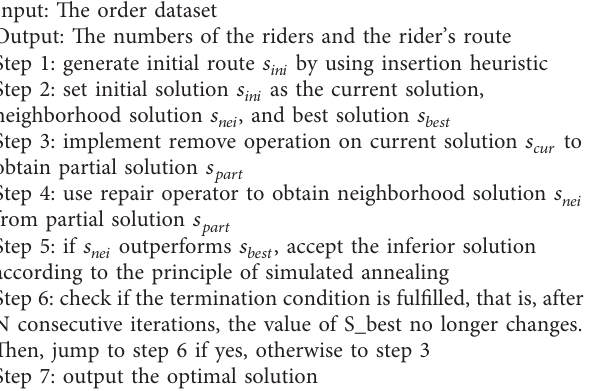
Table 3: The pseudo code of the heuristic